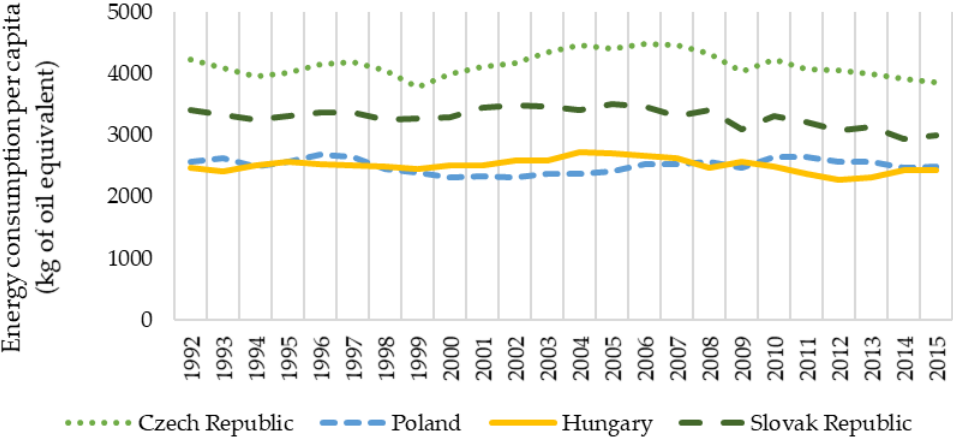
Figure 3. A plot of energy consumption per capita for V4 countries in 1992 – 2015 kg of oil equivalent.